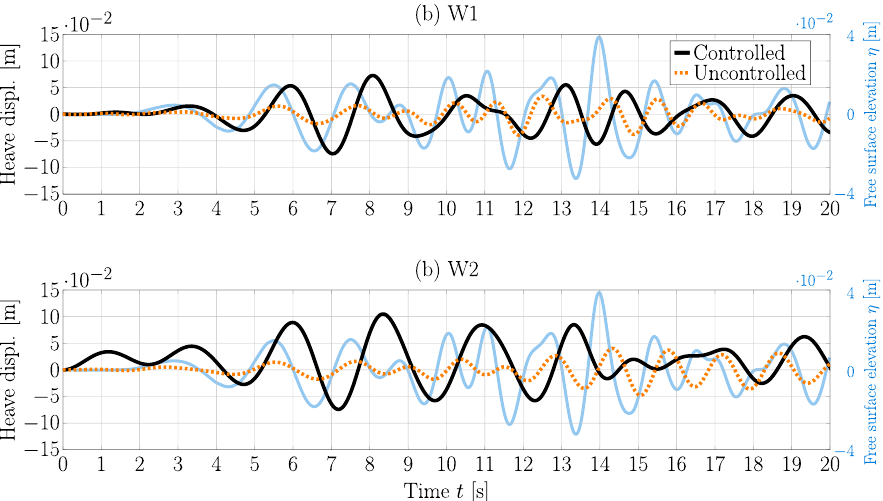
Figure 10. Time trace of the heave displacement of a controlled and uncontrolled WEC structures ( a ) W1 and ( b ) W2.